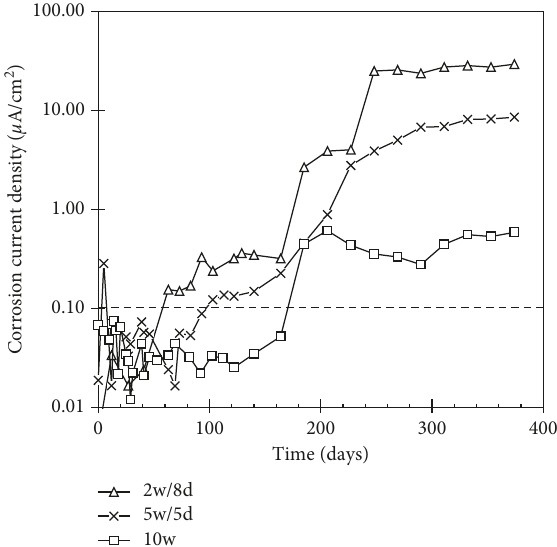
Figure 3: Changes in corrosion current density of the specimen exposed to the external